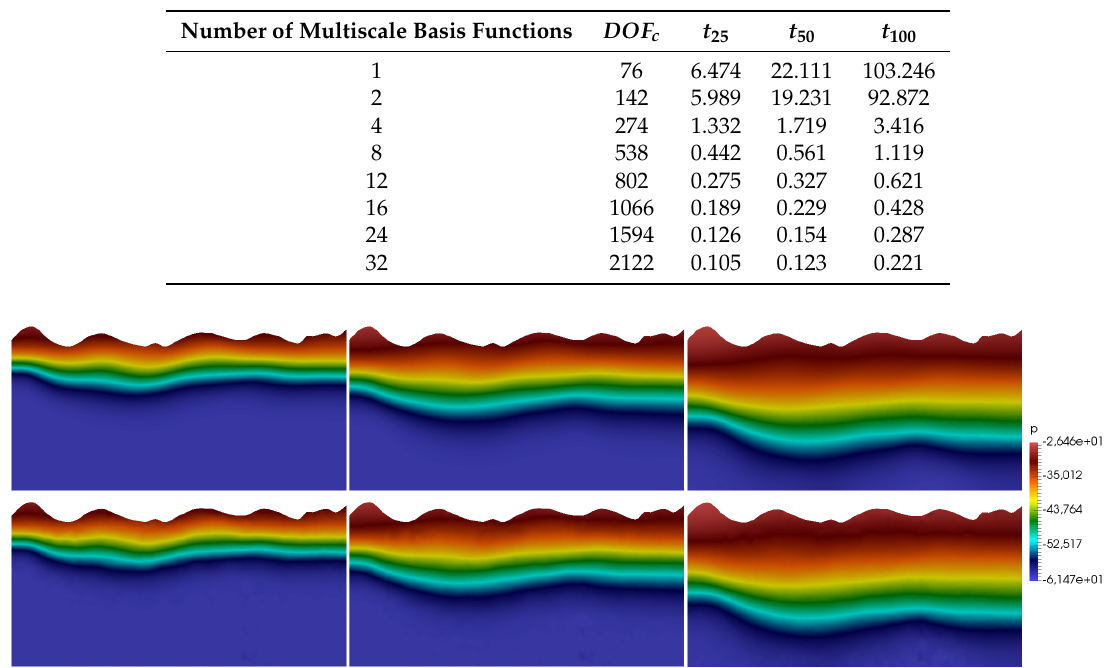
Figure 9. Numerical results for Test 1.RBC . Solutions p and p ms for different times: t 25 , t 50 , and t 100 (from left to right). First row: Fine-scale solution DOF f = 13,600. Second row: Multiscale solution using 16 basis functions DOF c =